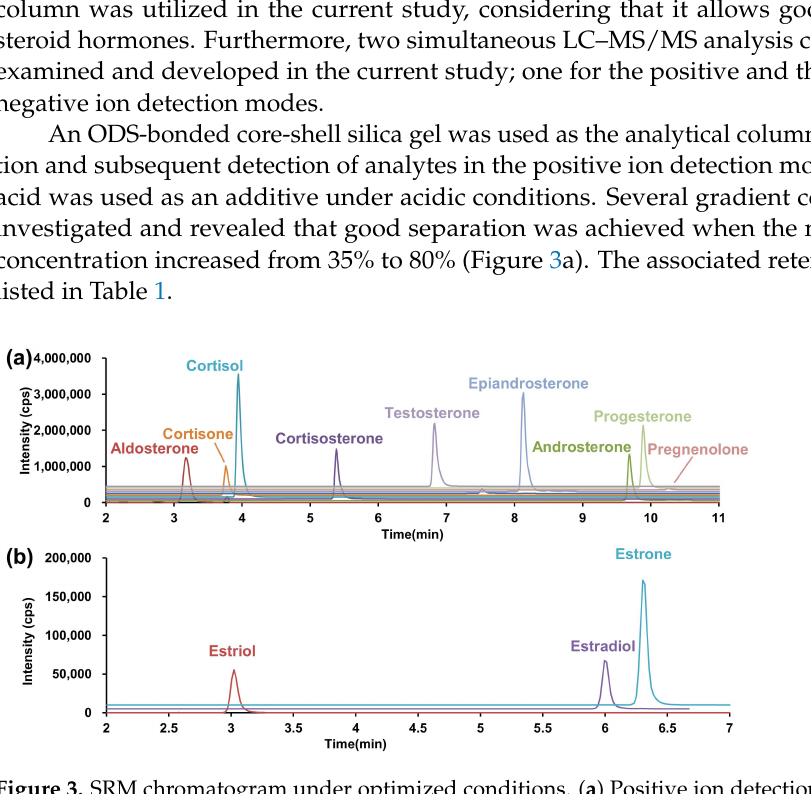
Figure 3. SRM chromatogram under optimized conditions. ( a ) Positive ion detection mode, ( b ) nega- tive ion detection mode. SRM, selected reaction